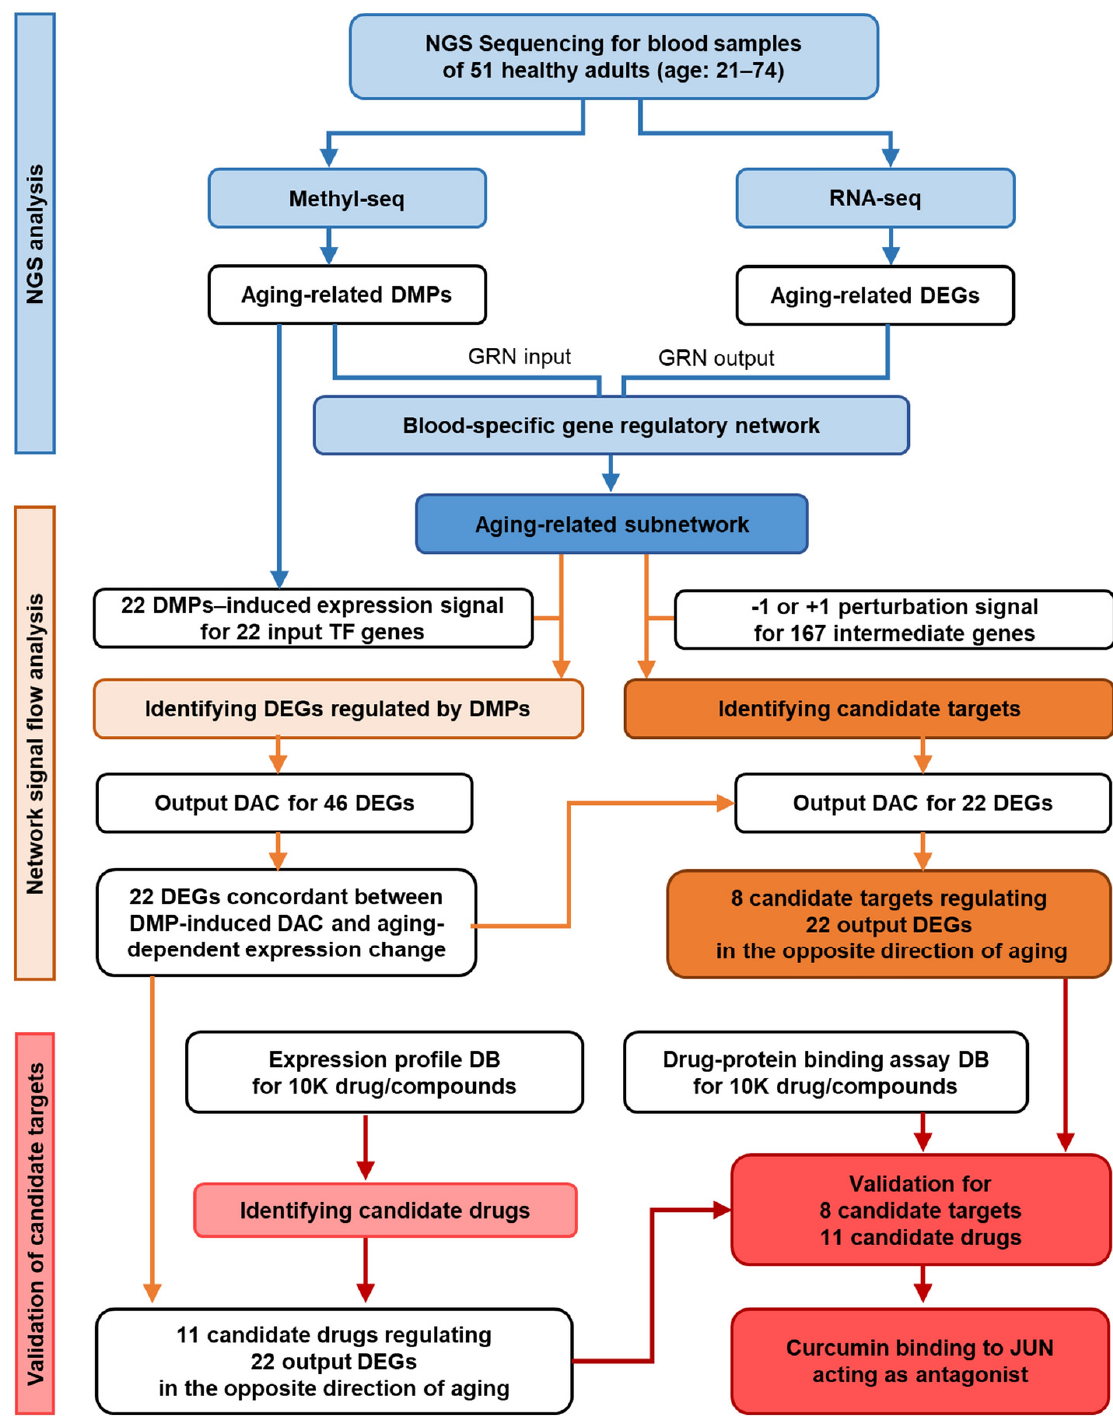
Figure 2. Identification process for anti − wrinkle drug molecular targets using AI [46].